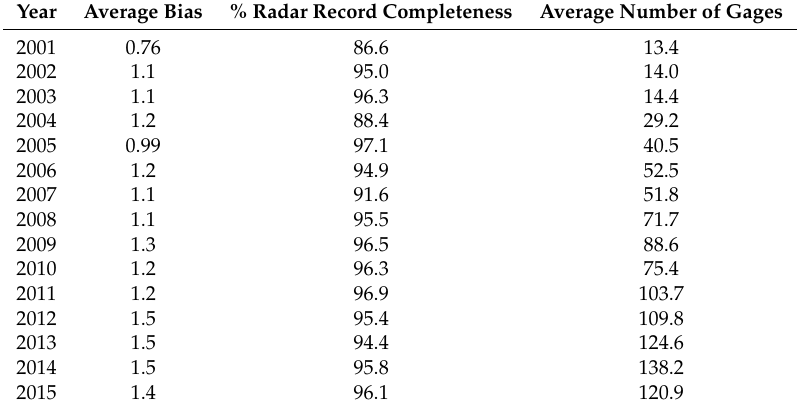
Table 1. Radar rainfall daily bias correction results by year. Columns detail the average multiplicative daily bias, the % completeness of 15-min radar rainfall periods, and the average number of rainfall gages used for the calculation of a daily